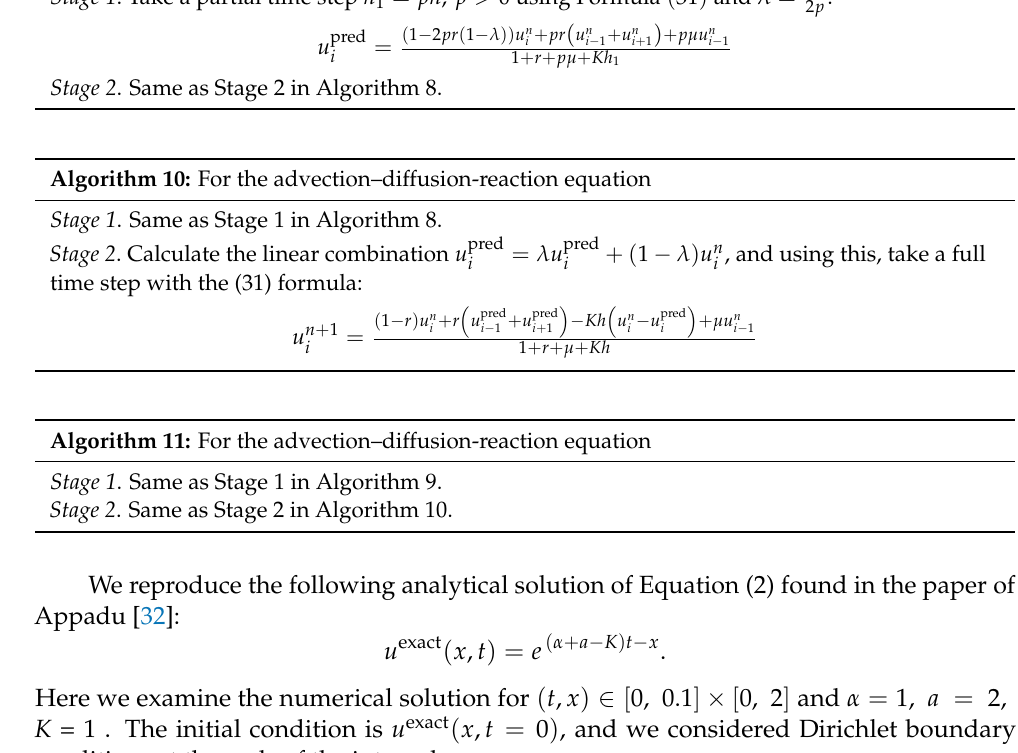
Algorithm 9: For the advection–diffusion-reaction equation